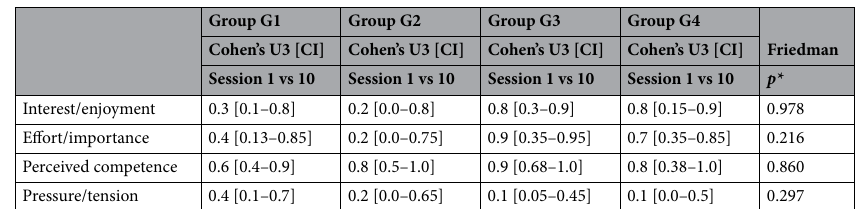
Table 3. The Cohen’s U3 coefficient demonstrated substantial differences in effect size between 1st and last session for IMI measure scales. *Statistically significant differences ( p < 0.05).